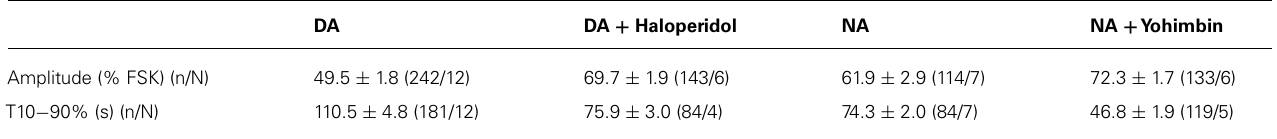
Table 3 | NA and DA effects involve alpha2 adrenergic and D2-like dopaminergic